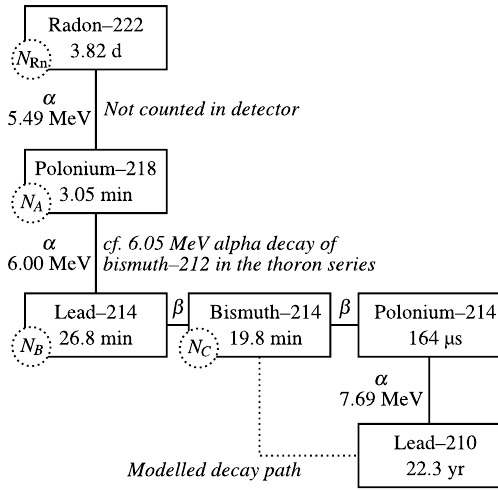
Figure 2. The decay series of radon and its immediate progeny, an extract from the uranium–238 series. The figure shows the energy of alpha decays, and nomenclature used to identify species abun- dances: N Rn , N A , N B , and N C